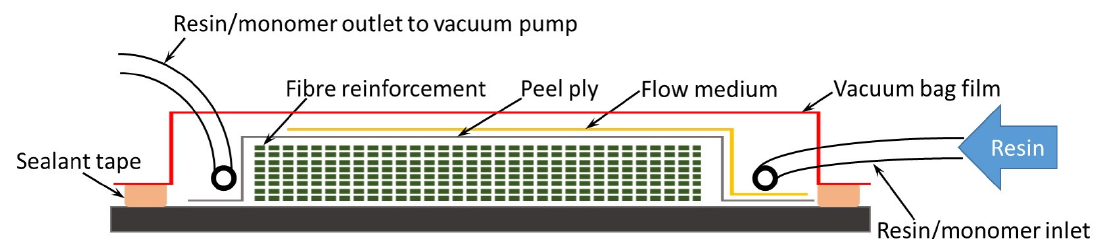
Figure 1. Schematic of the monomer infusion under flexible tooling (RIFT /